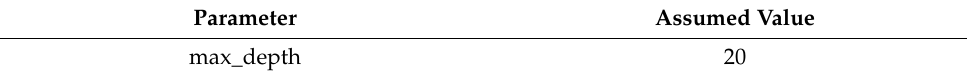
Table 3. Decision Tree hyperparameters settings.